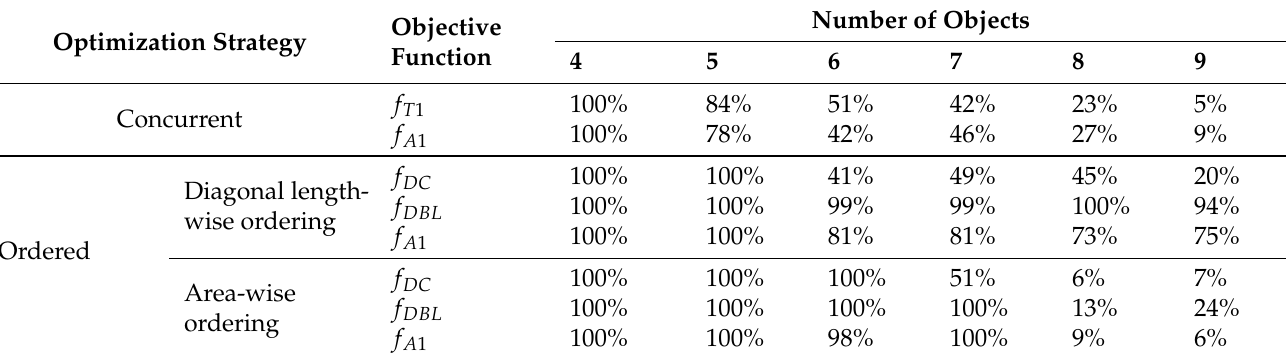
Table 2. Success percentages in packing all objects of each set given in Table 1 for different optimization strategies and objective